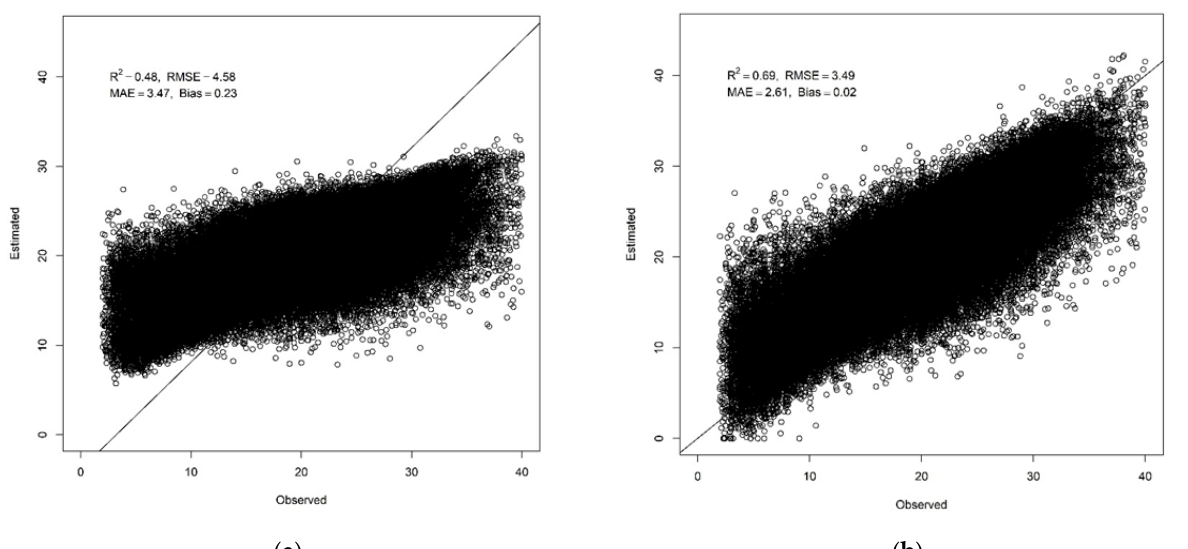
Figure 2. Scatter plot of observed and estimated canopy height at 30 m spatial resolution from the independent validation for ( a ) random forest and ( b ) regression kriging.